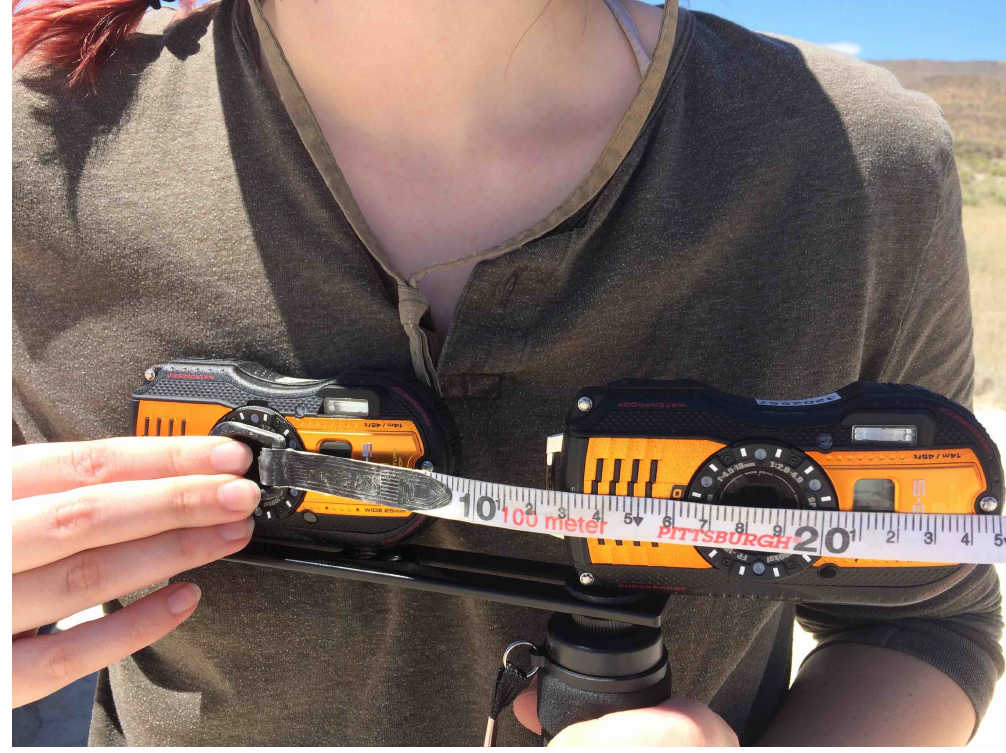
Figure 2. Our camera set-up, mounted on the